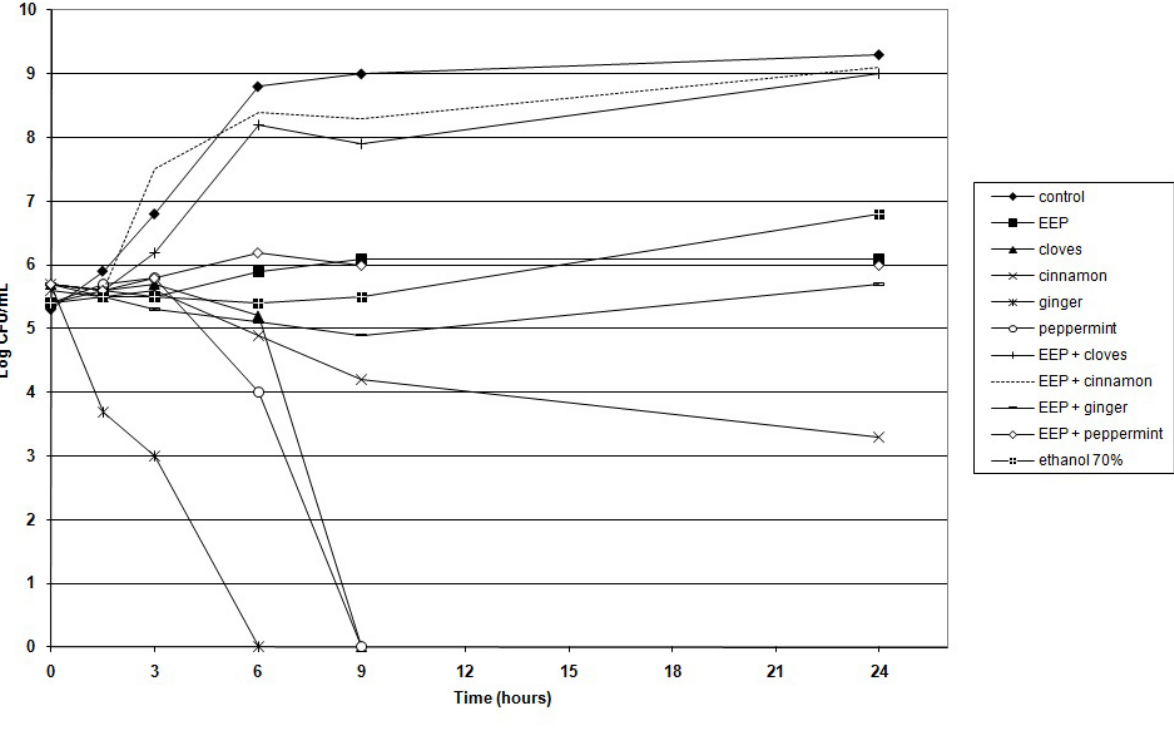
Figure 1. Log CFU x mL –1 values in the time-kill curve of MIC combination with one quarter of MIC